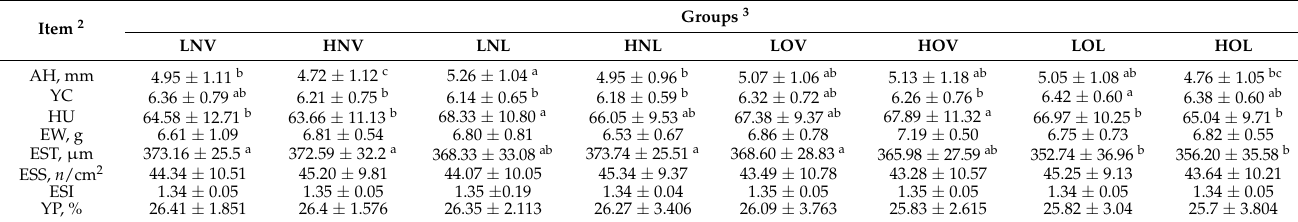
Table 4. Effect of vegetable oil and lard with different qualities and concentrations on egg quality of laying hens 1 .